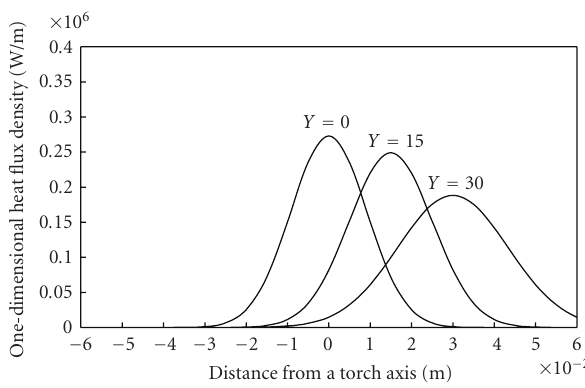
Figure 3: Typical variations in the heat flux profile in the arc root with increase of Y .